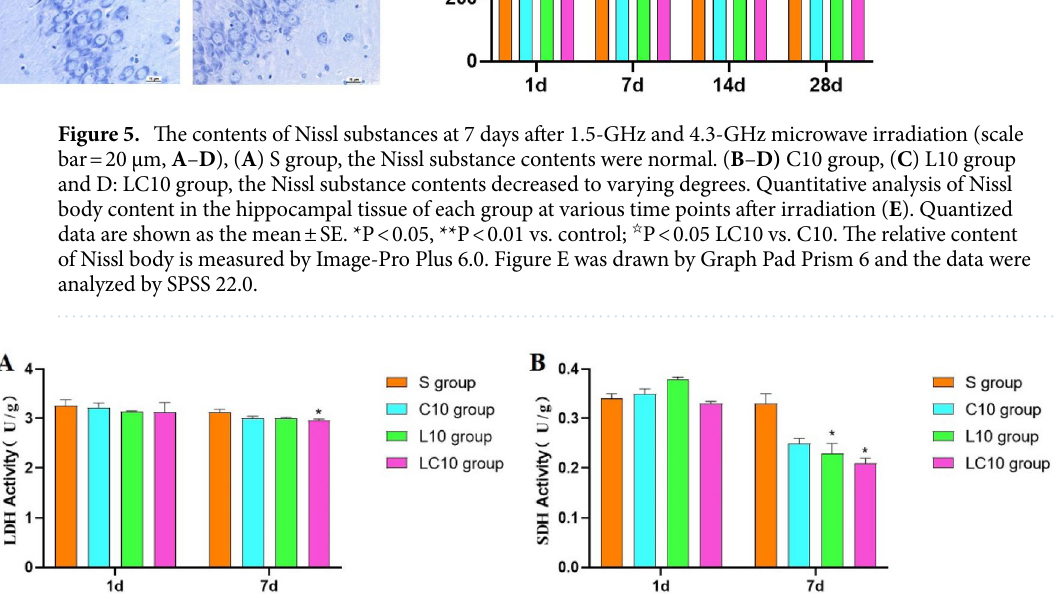
Figure 6. Changes in LDH and SDH activity at 1 day and 7 days after 1.5-GHz and 4.3-GHz microwave irradiation. ( A ) Changes in LDH activity at 1 day and 7 days after radiation. ( B) Changes in SDH activity at 1 day and 7 days after radiation. Quantized data are shown as the mean ± SE. *P < 0.05, **P < 0.01 vs. control. Figure A and B were drawn by Graph Pad Prism 6 and the data were analyzed by SPSS 22.0.